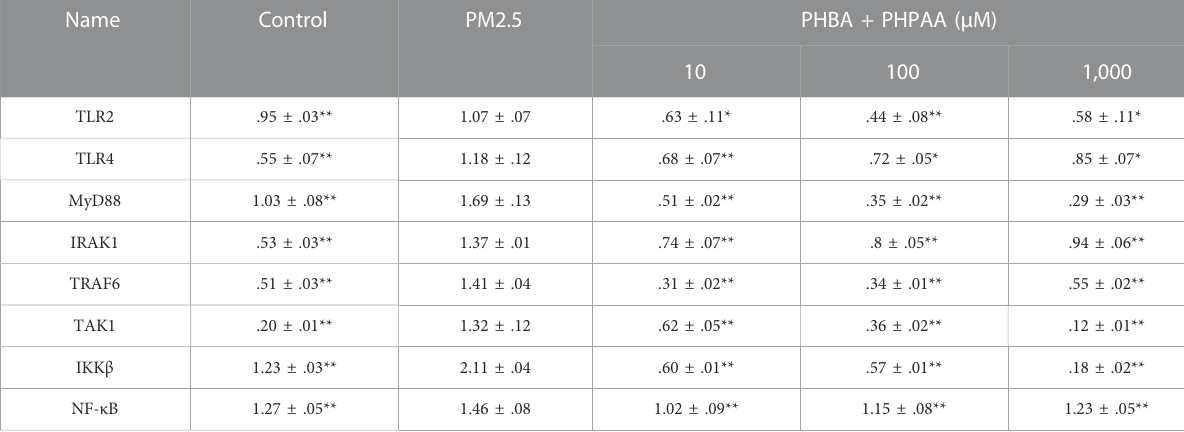
TABLE 4 Effects of PHBA combined with PHPAA on gene expression in TLRs related